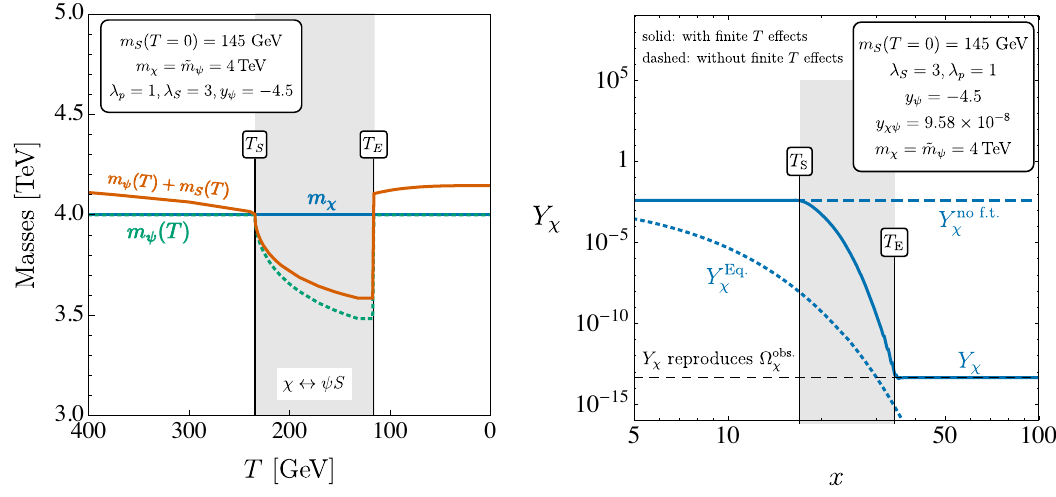
Figure 12 . Left: the masses of (cid:31) and as a function of temperature, along with the period where the channel (cid:31) $ S is kinematically allowed. Right: the evolution of the yield of (cid:31) as a function of temperature (solid) with the equilibrium yield of (cid:31) (dashed) and the yield which is required to obtain the observed relic abundance of (cid:31) (black,